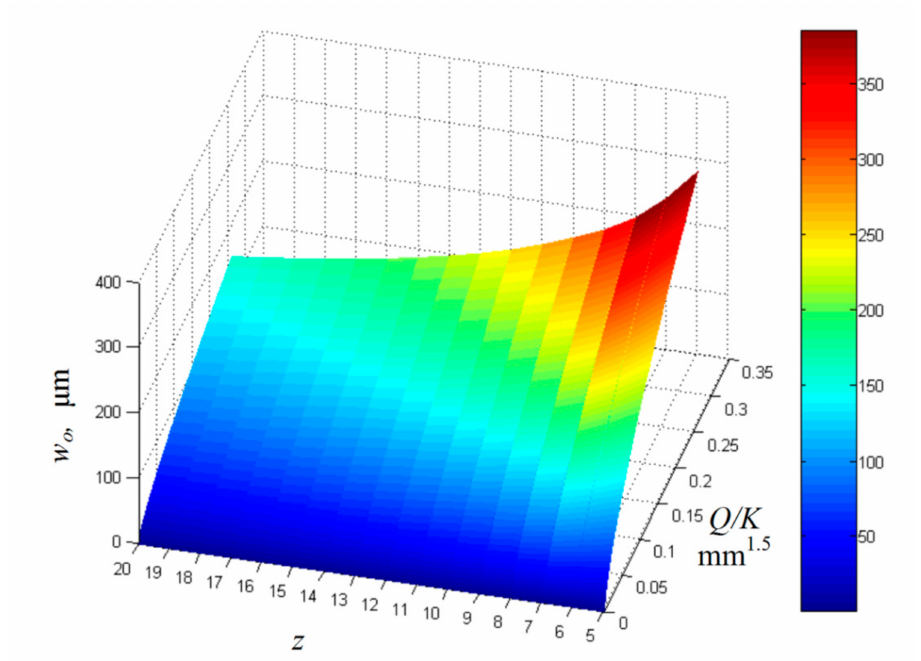
Figure 10. Three-dimensional dependence of bearing deflection ( w o ) on the total number of rolling elements ( z ) and level of external load ( Q ), for the BSO position of rolling bearing.